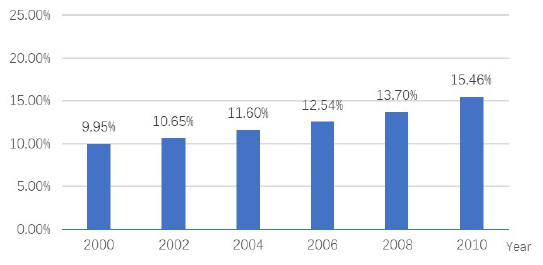
Figure 5 . Urban land area index of Yangtze River Delta.